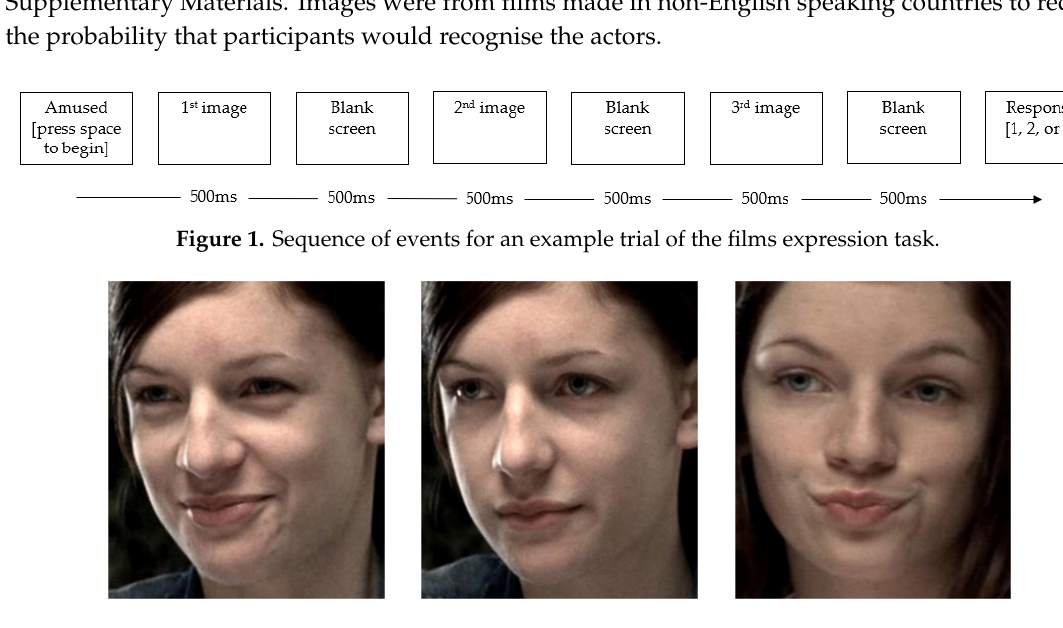
Figure 2. Images from an example trial [amused] of the films expression task.